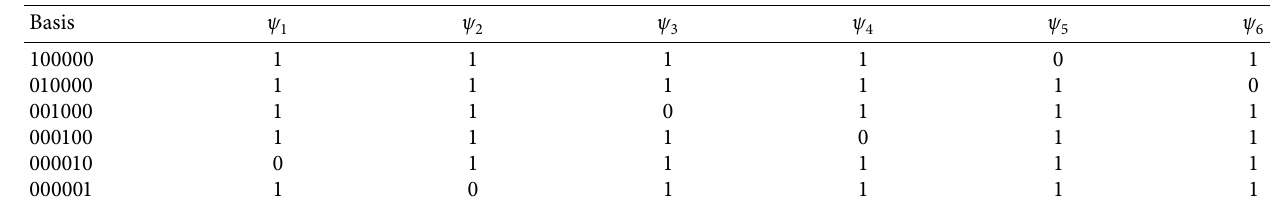
Table 2: Linear parts of each basis